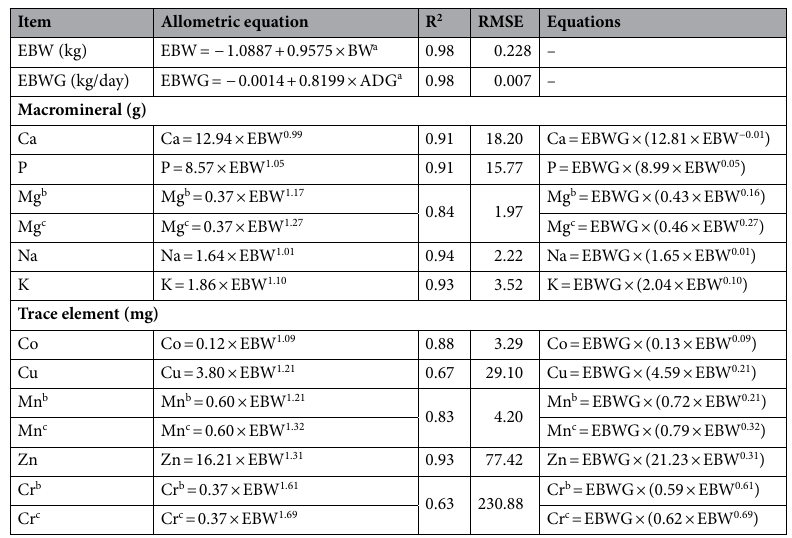
Table 4. Equations for estimating body composition and net gain requirements of intact and castrated male Santa Ines hair sheep. BW body weight, EBW empty BW, EBWG empty BW gain, ADG average daily gain, RMSE root mean square error. a According to Pereira et al. 9 ; b intact male; c castrated male.